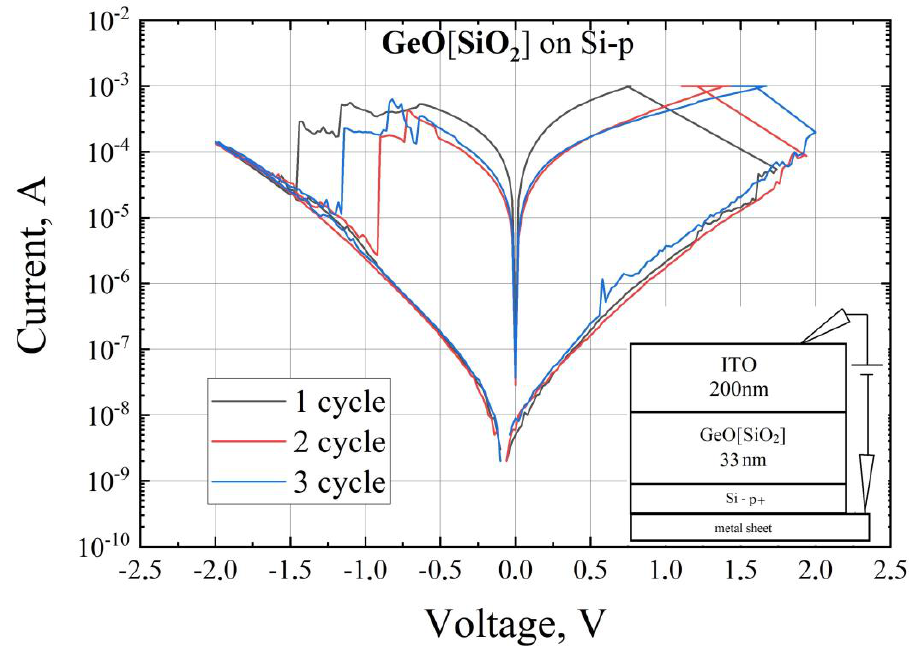
Figure 6. I–V curves of the sample Figure 6. I – V curves of the sample А .